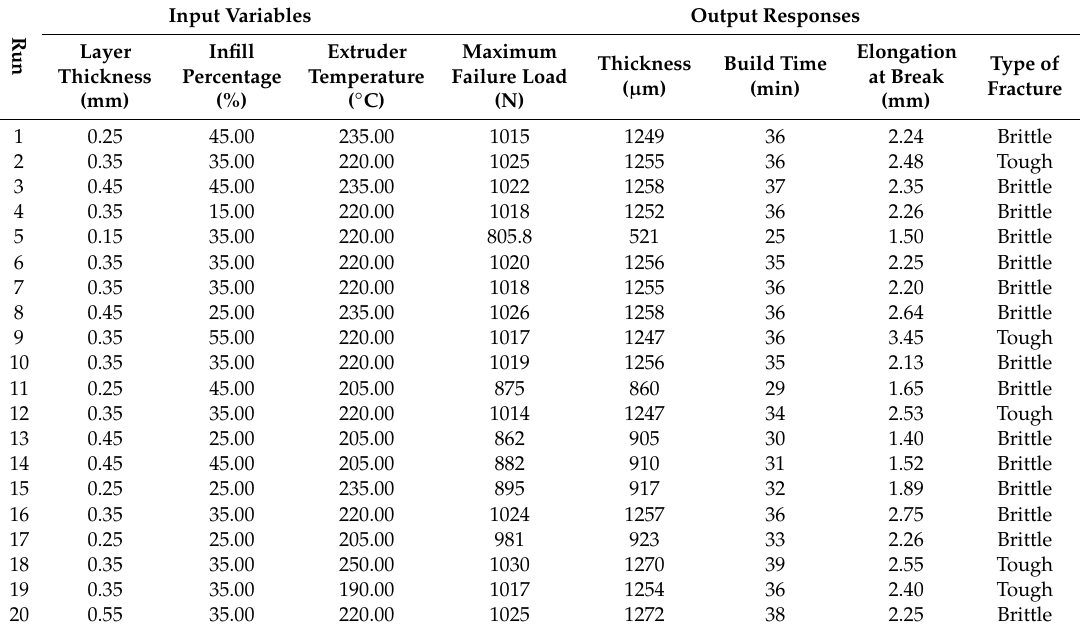
Table 2. Design matrix and experiments